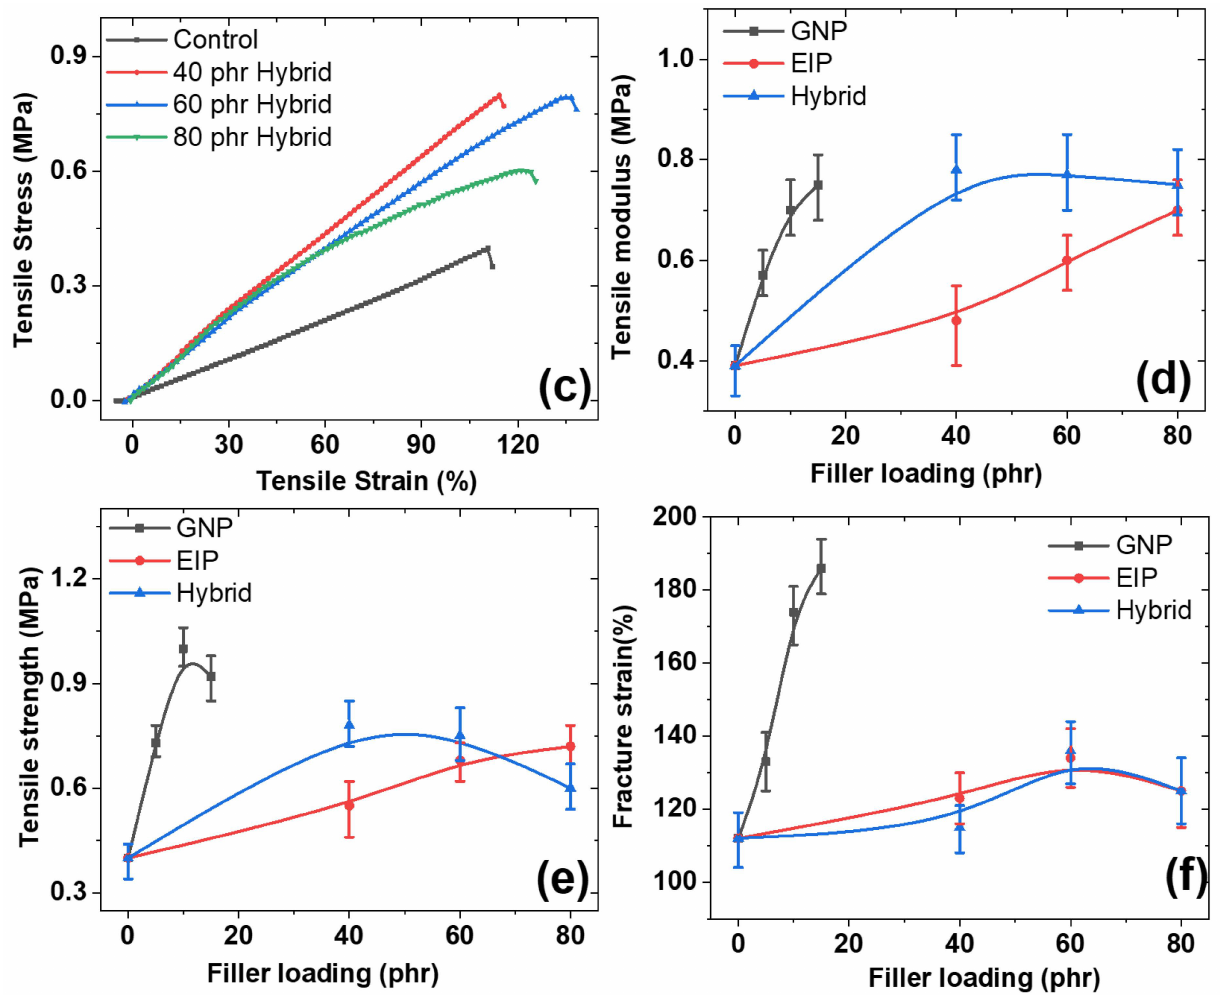
Figure 4. Stress–strain profiles under tensile strain: ( a ) GNP composites; ( b ) EIP composites; ( c ) hybrid composites; ( d ) tensile modulus of different composites; ( e ) tensile strength of differ- ent composites; ( f ) fracture strain of composites.